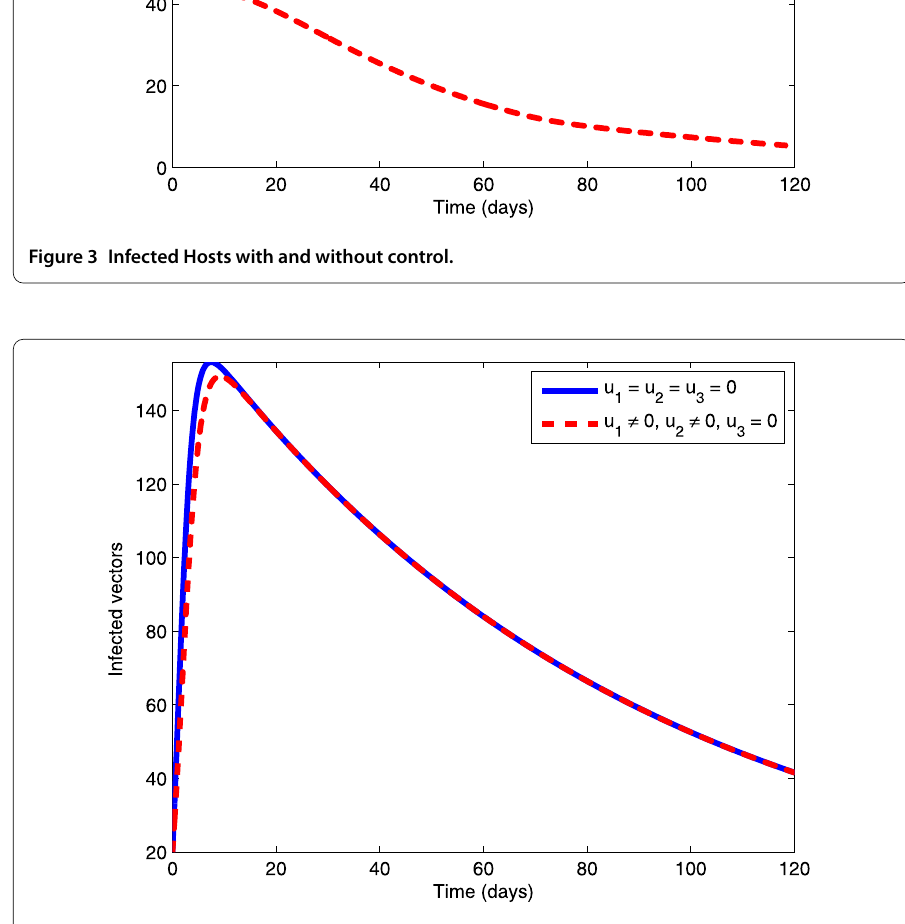
Figure 4 Infected Vectors with and without